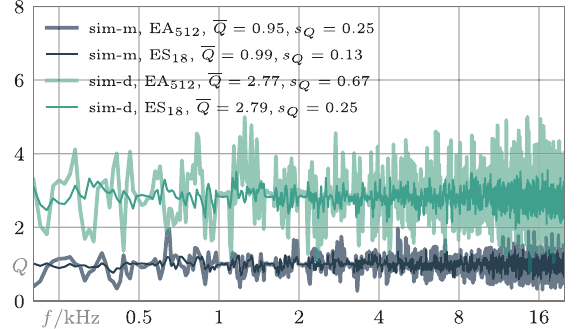
Figure 17. Frequency-dependent directivity factor of the simulated sources.